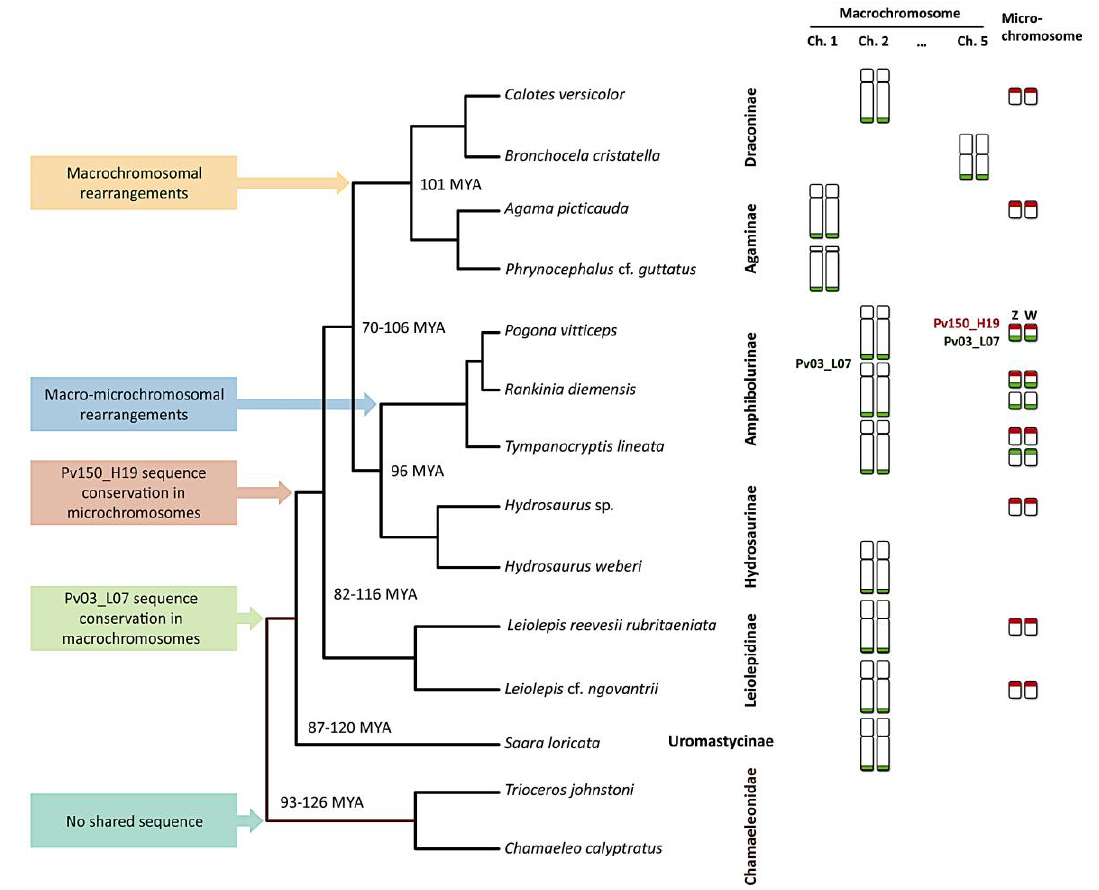
Figure 3. Cross-species chromosome mapping of P. vitticeps sex-chromosome-derived BAC probes Pv03_L07 (in green) and Pv150_H19 (in red) highlighting hypothetical evolutionary scenarios of chromosome rearrangements within the subfamilies of Agamidae. Truncated phylogeny (not according to scale) is adopted from Pyron, et al. [24]. Known divergence times are provided in million years ago (MYA) [25,30,66].